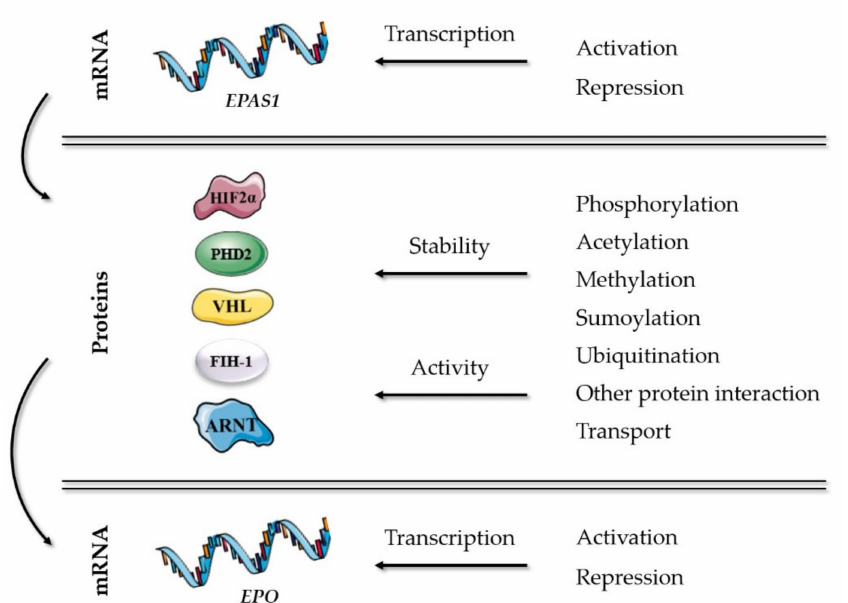
Figure 1. Molecular mechanisms in the HIF-EPO pathway, which can modulate the stability or activity of HIF2 α and its partners correlated with